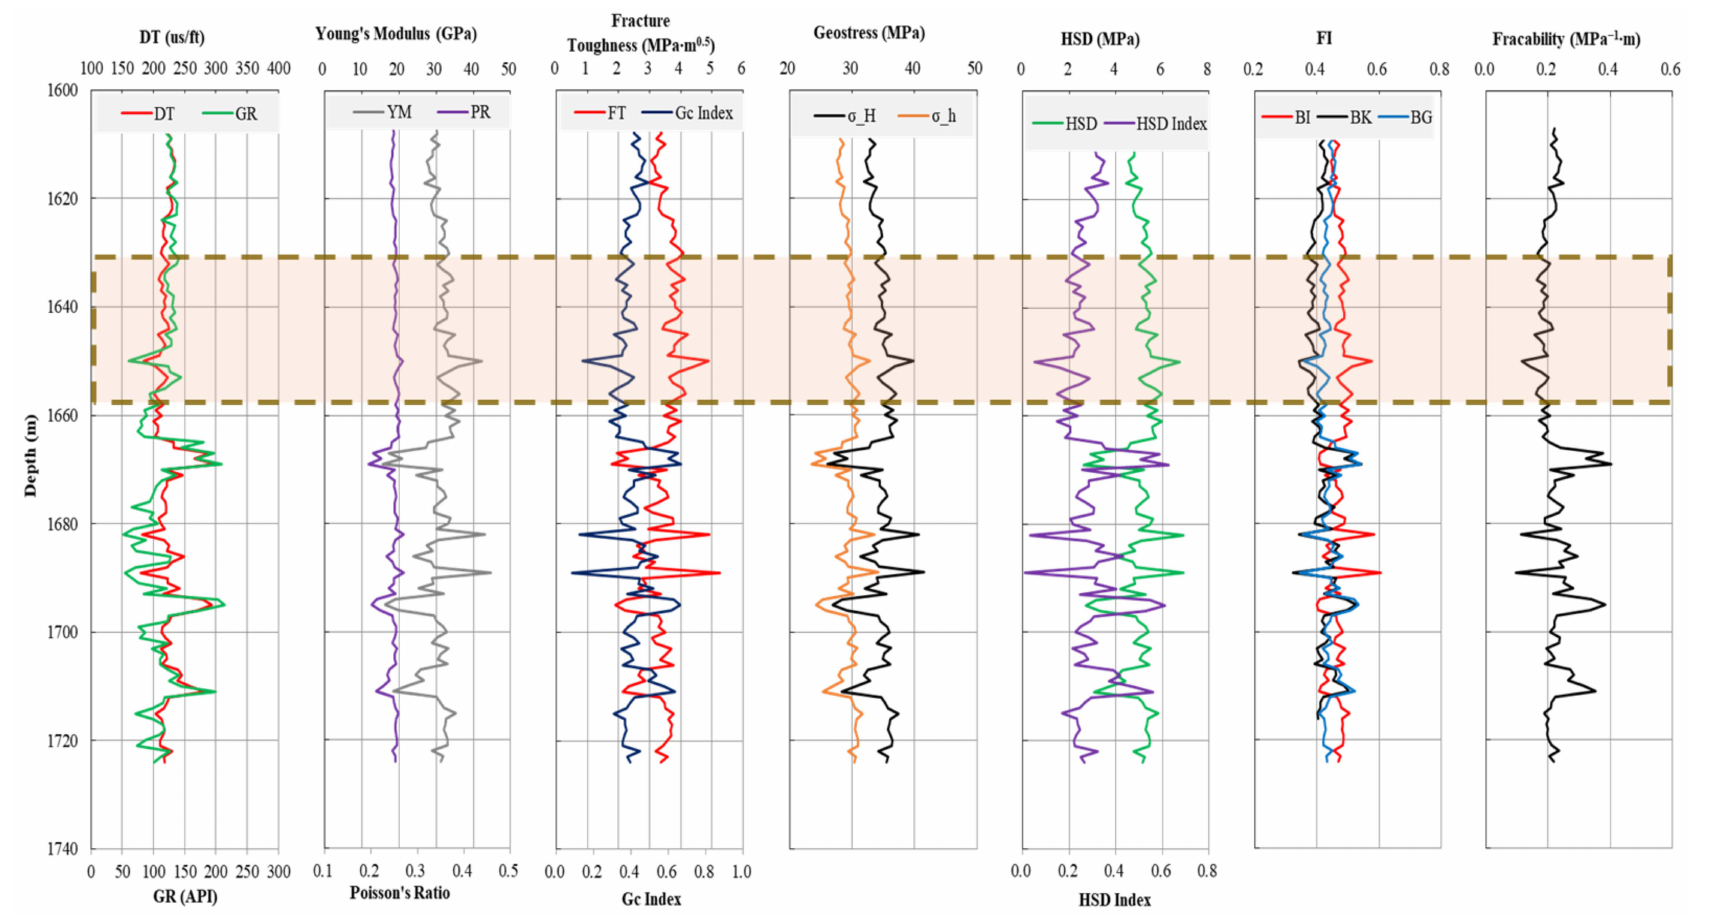
Figure 6. Profiles of fracability and other key parameters from Well